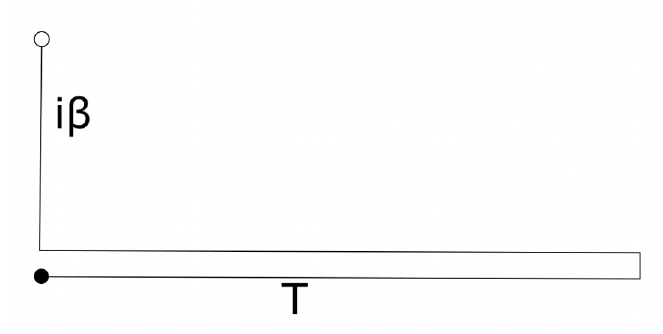
Figure 3 . A Schwinger-Keldysh contour evolves forwards in time by T , then backwards by T , then by iβ in imaginary time. It is often used to calculate dynamical correlations in a thermal back- ground. When identical sources are present on the forward and backwards legs, the partition func- tion on this contour is equal to the traditional thermal partition function. But when the sources dif- fer, the partition function on this contour is decreased by an amount related to the Loschmidt